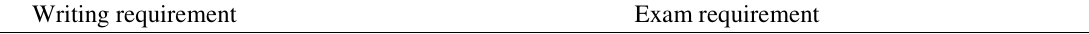
Table 1: Writing and exam